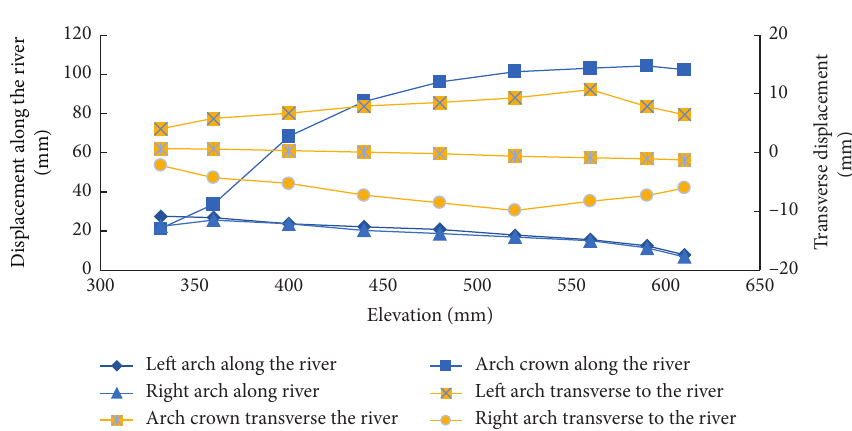
Figure 6: Displacement characteristic curve of the arch dam under normal load combination.